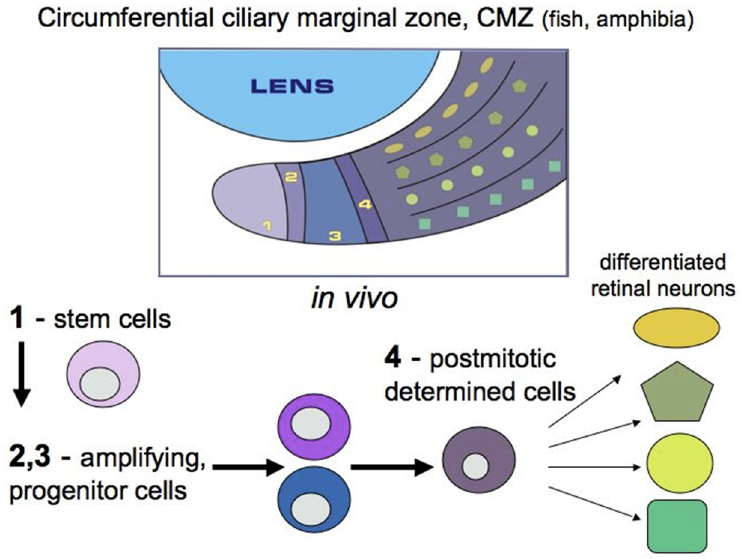
Figure 3. Postembryonic growth of the eye through cell division at the ciliary marginal zone in lower vertebrates. 1–4: The CMZ can be divided into several zones, from peripheral to central, which reflect different stages of the development of retinal stem cells. (In accordance with [31]). Tailless amphibians, such as, in particular, the African clawed frog Xenopus laevis , have also